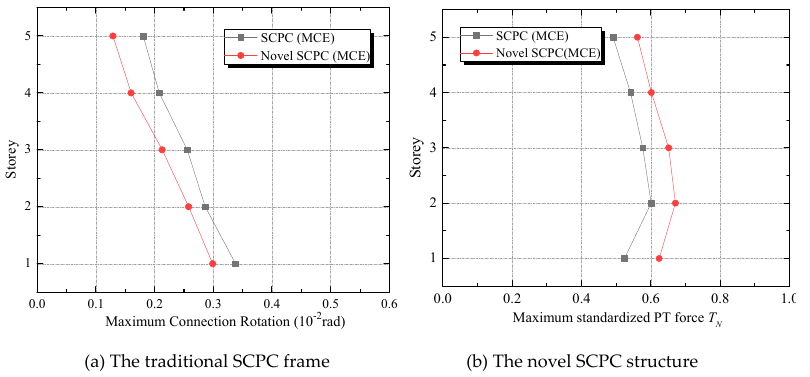
Figure 26. Maximum inter-story shear force of three frames at MCE level. Figure 27. Maximum connection rotation and standardized PT force of two SCPC frames.